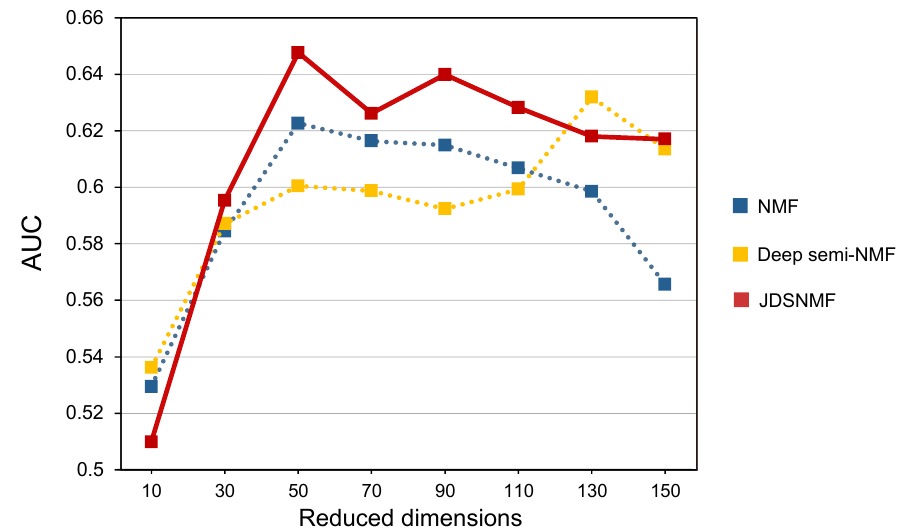
Figure 5. Comparison of classification performance on the Alzheimer’s Disease Neuroimaging Initiative cohort. Average area under the curve (AUC) values of SVM, RF, and DNN for AD/NL classification by each model with respect to reduced